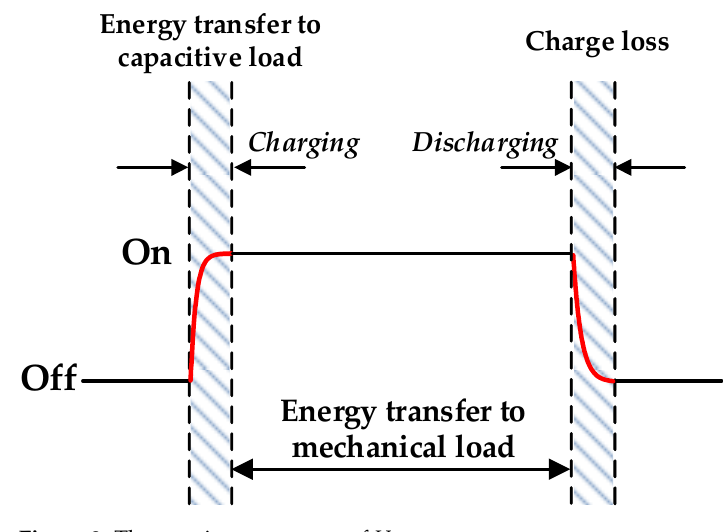
Figure 3. The quasi-square wave of V p .